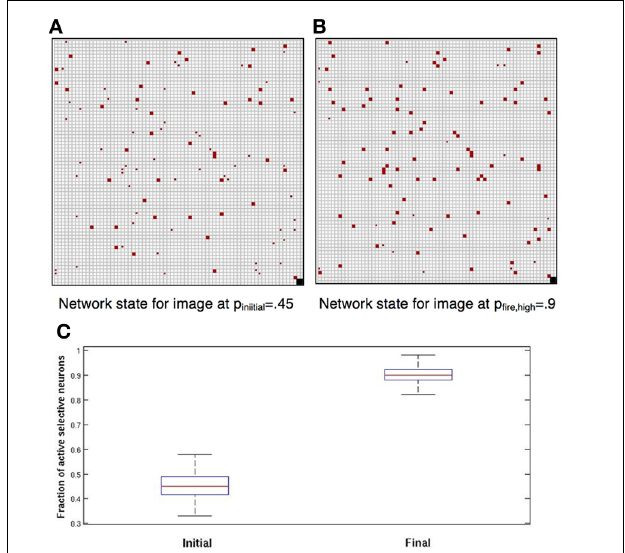
FIGURE 1 | Completion. Each square corresponds to a neuron. Blank squares are inactive non-selective neurons. Grid arrangement is just for presentation—network has no topological structure. (A) In red the selective neurons of the image. Full squares—active. Small dots—inactive. Initially approximately 45% are active; we set pinitial = 0.45. (B) Completion: after network dynamics with p fire , high = 0.9, approximately 90% of selective neurons are active. (C) Box plots showing, for 100 simulations, the distribution of the fraction of active selective neurons, immediately following initial presentation and after completion by network dynamics (red line: median; top and bottom of box: upper and lower quartiles; horizontal lines: quartiles ± 1.5 interquartile